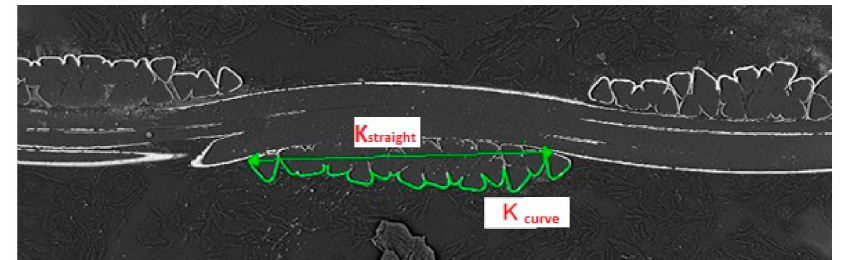
Figure 2. Evaluation of the width of the multifilament yarns K straight and the length of coating of multifilament yarns in cross-section K curve